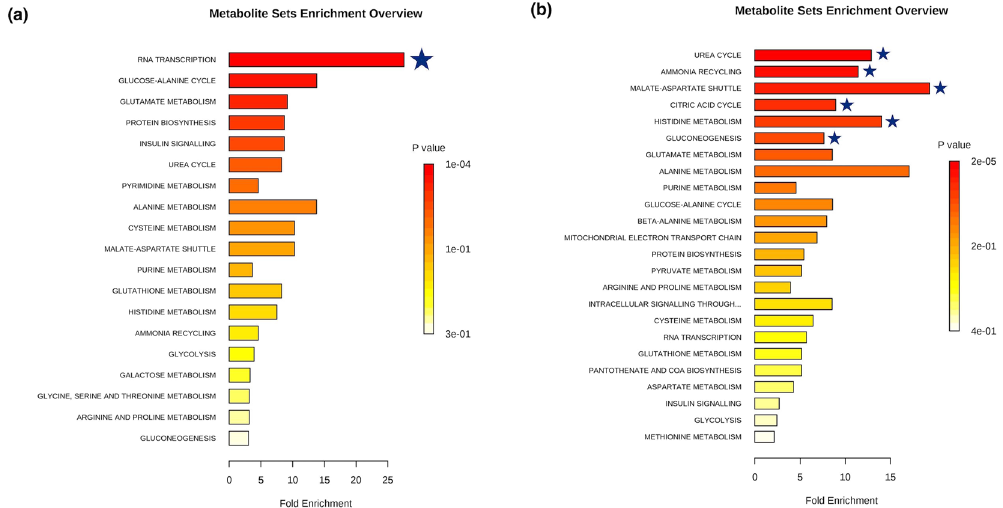
Figure 5. Metabolite set enrichment analysis based on differentially expressed metabolites identified in plasma ( a ) and urine ( b ) from Hhip + / − heterozygotes exposed to chronic cigarette smoke relative to mice exposed to room air. Metabolite sets significant at an FDR < 0.05 are denoted with a blue